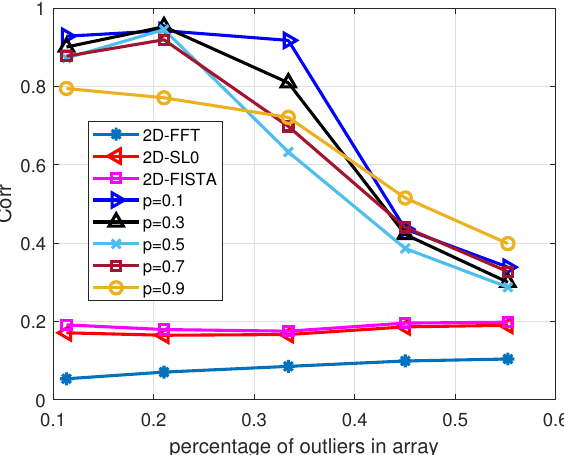
Figure 7. The relationship between the percentage of outliers and the Corr.